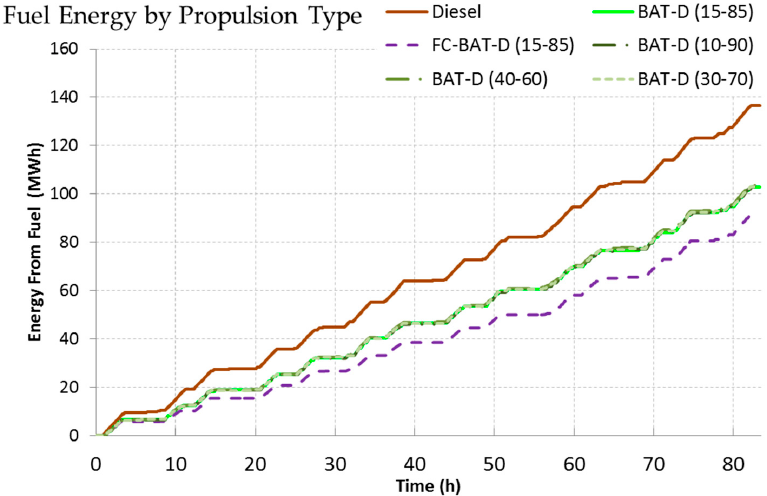
Figure 20. Propulsion power during the tested transition route of SWATH II type vessel. Energies 2020 , 13 , x FOR PEER REVIEW